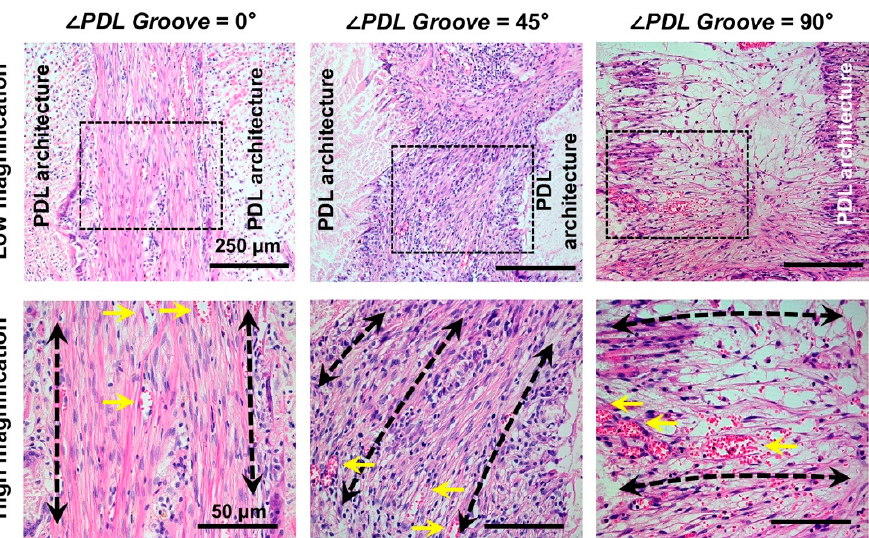
Figure 5. H&E histology is evaluated for fibrous tissue formation and orientations between PDL- guiding architectures at 6 weeks. Black arrowed-dash lines represent the fibrous tissue directionality. Yellow arrows indicate blood vessels. The scale bars of low magnification and high magnification are 250 µ m and 50 µ m,